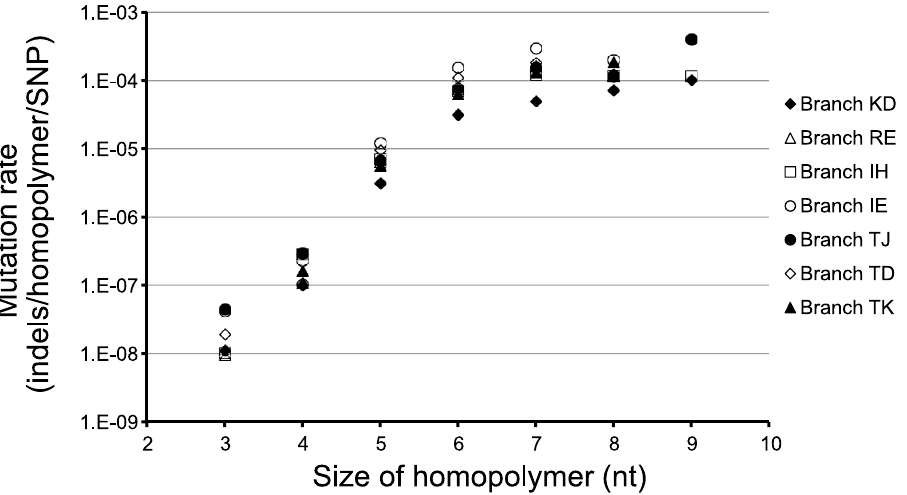
Figure 4. Mutation rates of homopolymers. Rates of mutation of homopolymers of different sizes are shown for seven DK2 sub-lineages evolving with a mutS/mutL DNA MMR-deficiency. The rates were calculated as the number of observed indels per homopolymer per mutS/mutL MMR- deficiency caused SNP (see Materials and Methods).